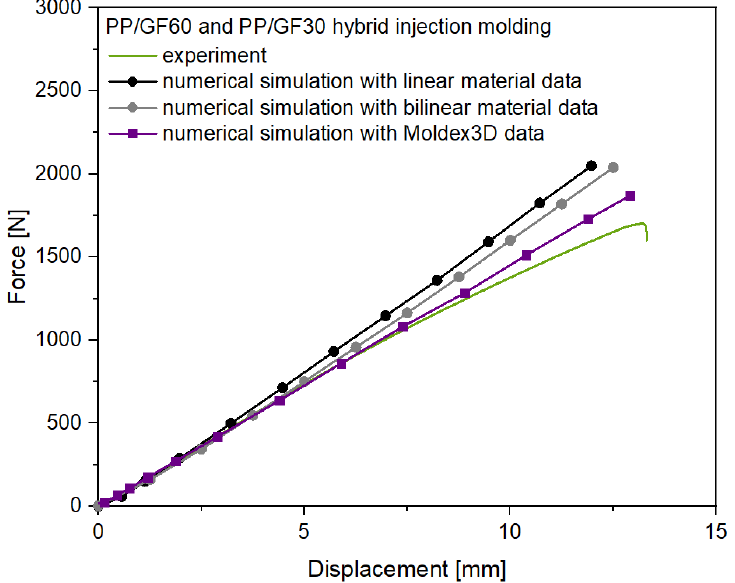
Figure 16. Experimental and numerical results for the flexural test of the PP/GF60 and PP/GF30 hybrid injection molded thermoplastic composite test structure.